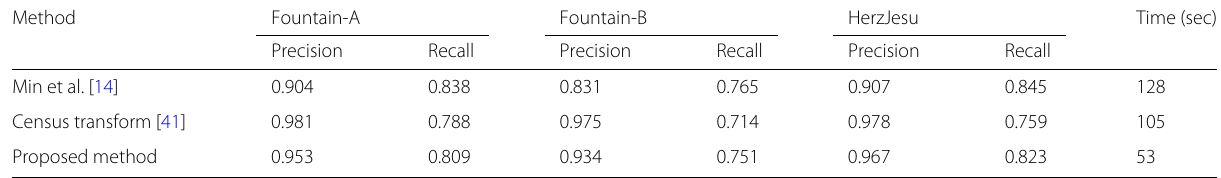
Table 2 Performance comparison of three methods on the fountain and HerzJesu dataset Method